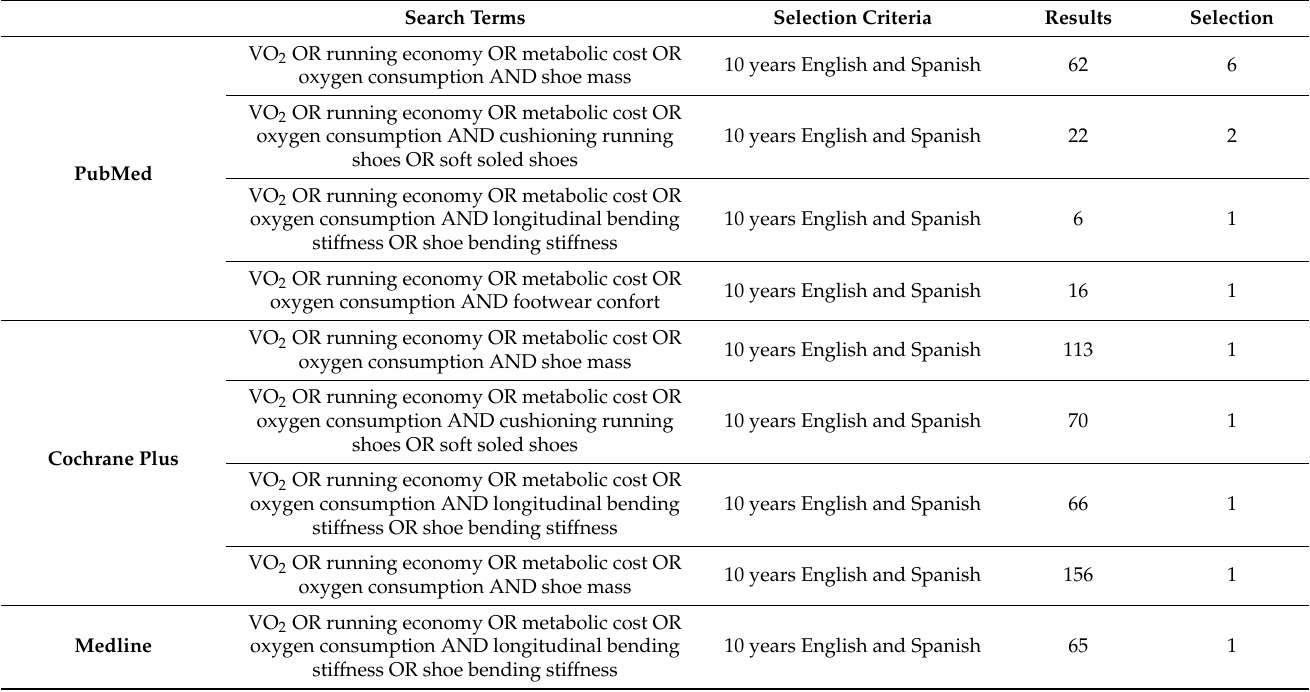
Table 1. Search strategy